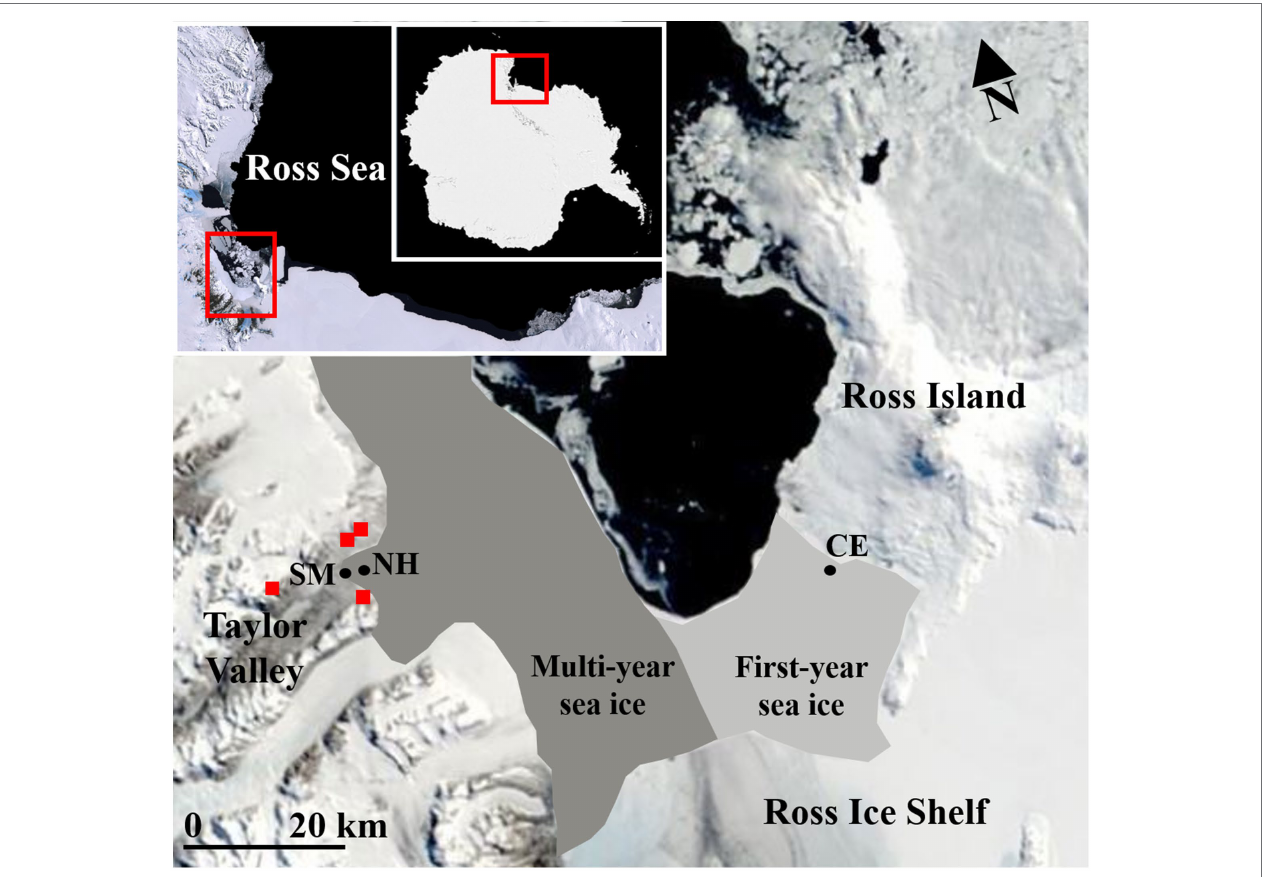
FIGURE 1 | Moderate Resolution Imaging Spectroradiometer (MODIS) satellite imagery of McMurdo Sound and McMurdo Ice Shelf region during November 2017 with sample site locations [Cape Evans, CE (14.2 m); Explorers Cove, New Harbour, NH (18.5 m); the shoreline moat, SM (~0.1 m)]. The locations for four New Zealand Terrestrial Antarctic Biocomplexity Survey (nzTABS) terrestrial soil samples within the lower Taylor Valley are represented by red squares. Regions historically dominated by multi-year sea ice (dark grey) vs. first-year sea ice (light grey) are overlaid on the map (indicative only). Brackish water is present at the shoreline moat site during months of sunlight. Image credit: MODIS, NASA, United